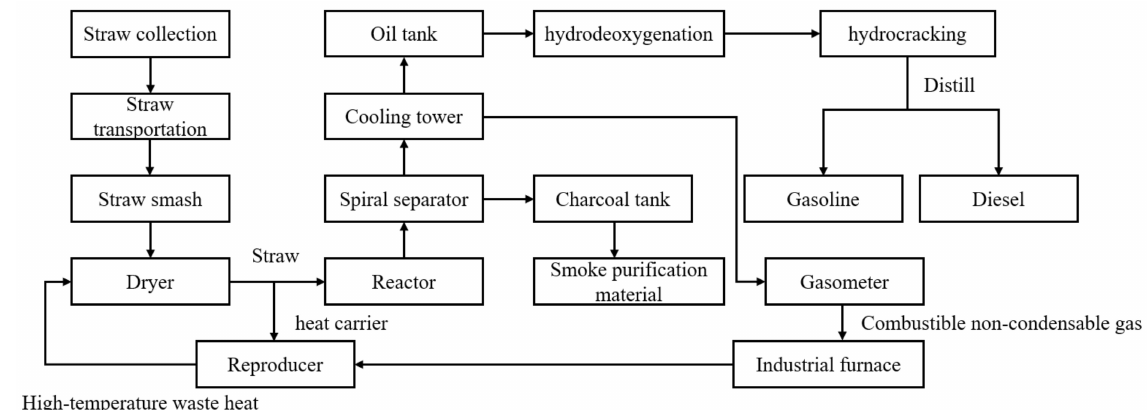
Figure 1. Technological process of the non-phase-transition drying pyrolysis and mass conversion